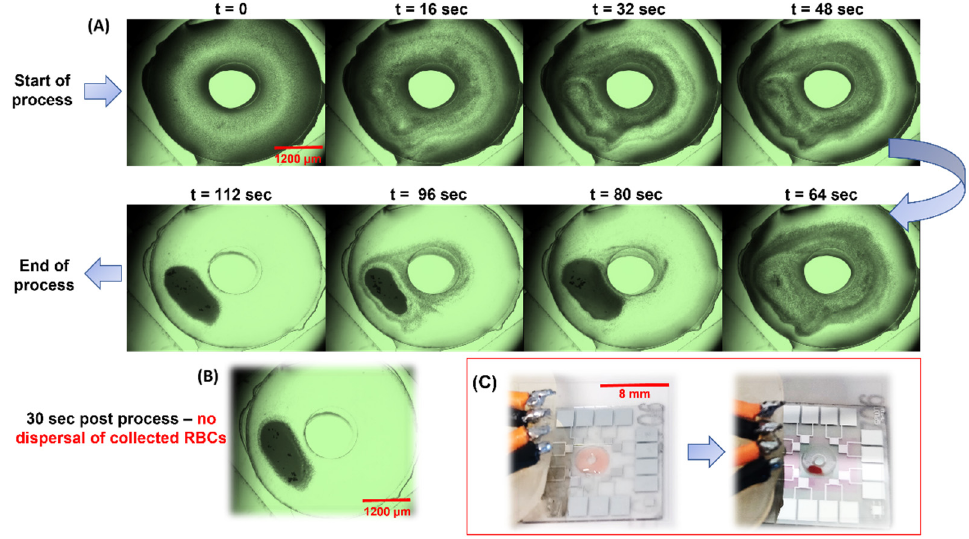
Figure 6. ( A ) The results from running 1:20 human blood at 285 MHz with a load volume of 3 µL. Starting from the top-left (t = 0 s), each window represents a time difference of 16 s from the previous one. ( B ) Image snaps of the device pre-run and post run. Note the mass of RBC does not diffuse back even 10 s after device stop. (Refer to SV2 for real-time videos of one set of the trial). ( C ) The working of the device when seen with the unaided eye—note the clear accumulation of the RBCs leaving behind the clear fraction that could be extracted using a micropipette.